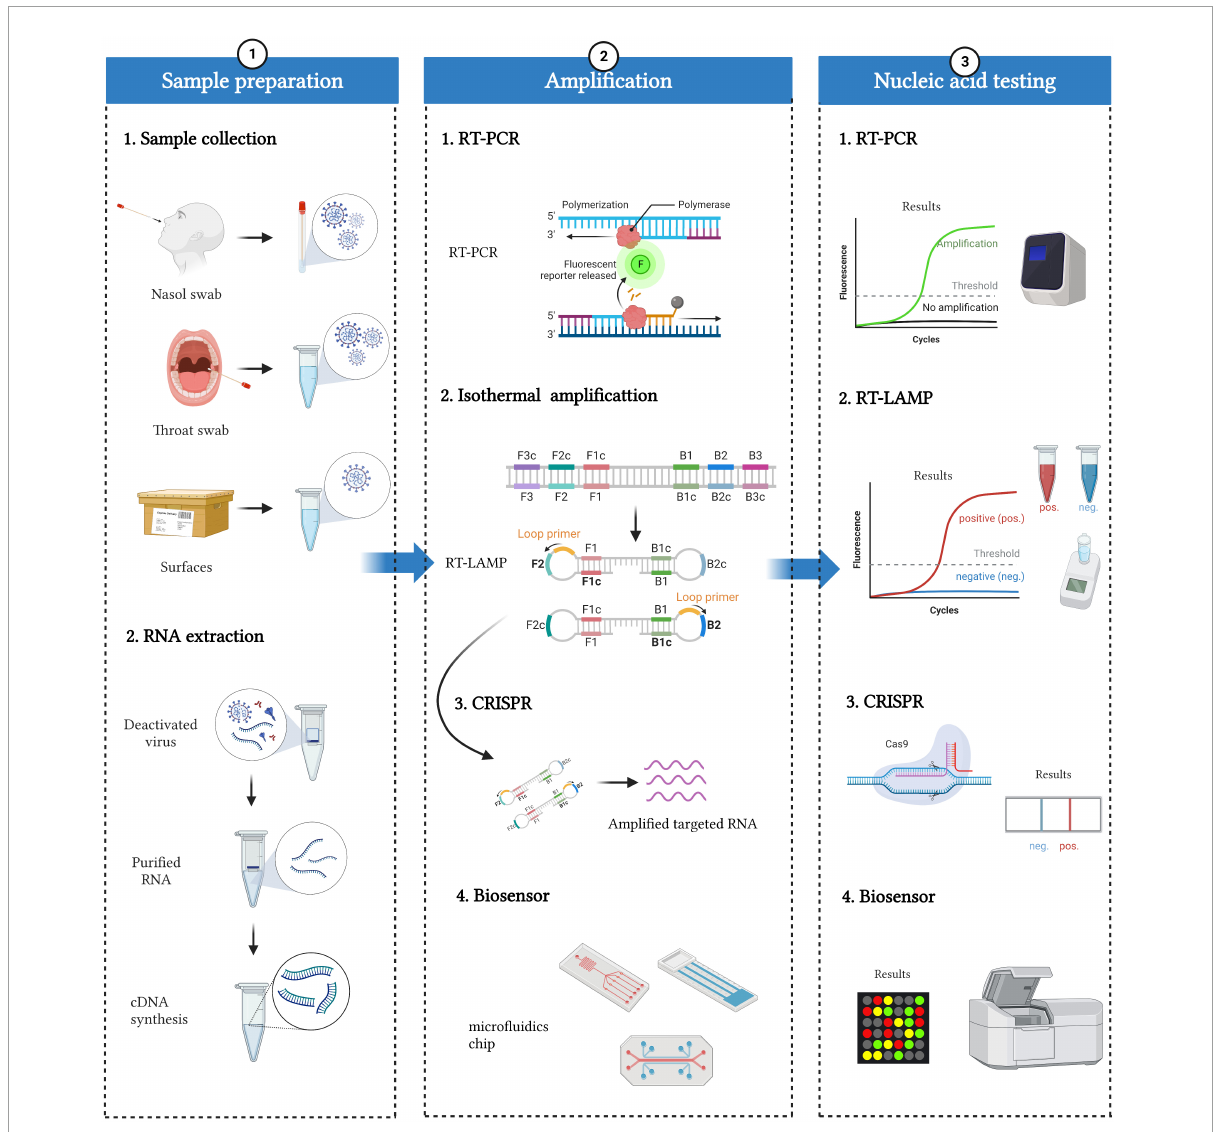
FIGURE2 Workflow of SARS-CoV-2 nucleic acid detection. The whole detection process can be divided into three parts: sample preparation, amplification, and nucleic acid testing. Sample preparation included sample collection and RNA extraction. Specimens mainly come from people (such as nasal swabs and throat swabs) and the environment (such as the surface of packages). RNA can be extracted from deactivated virus, and then cDNAs are synthesized based on reverse transcriptase. Various nucleic acid amplification methods, including RT-PCR, isothermal amplification, CRISPR, and biosensors, can be applied to amplify and detect